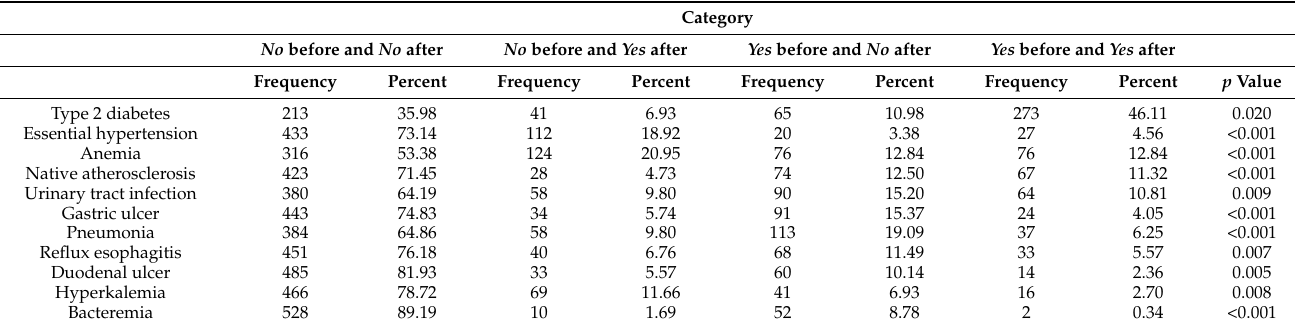
Table 2. Hospitalization status before and after